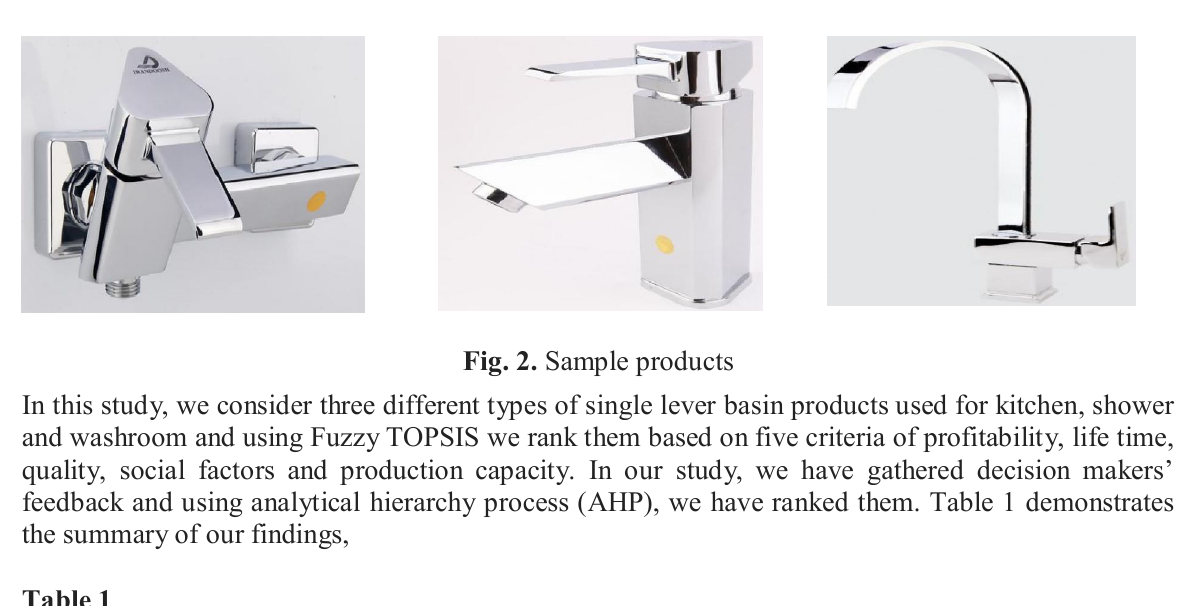
The results of ranking different alternatives using AHP method Criterion